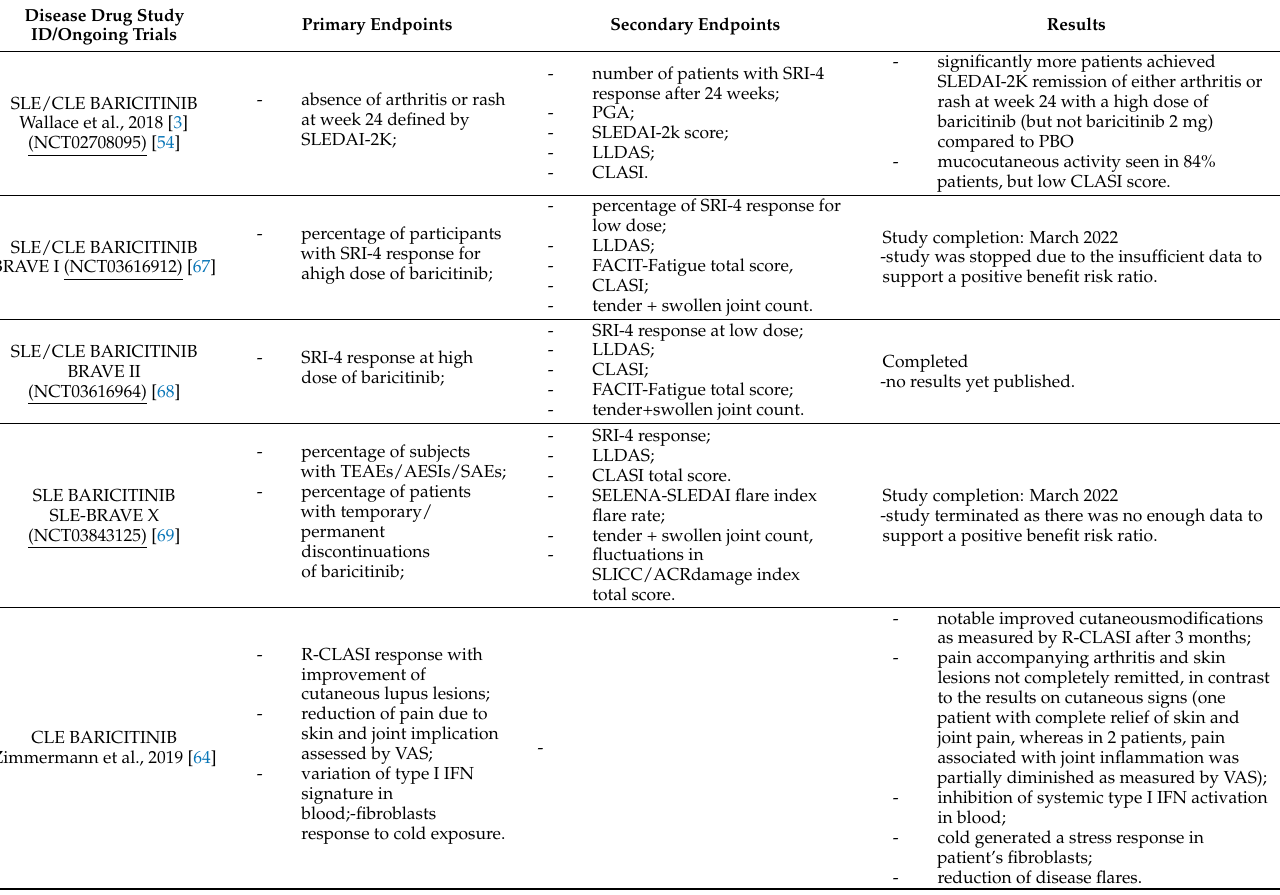
Table 4. Baricitinib-main results of clinical trials in SLE